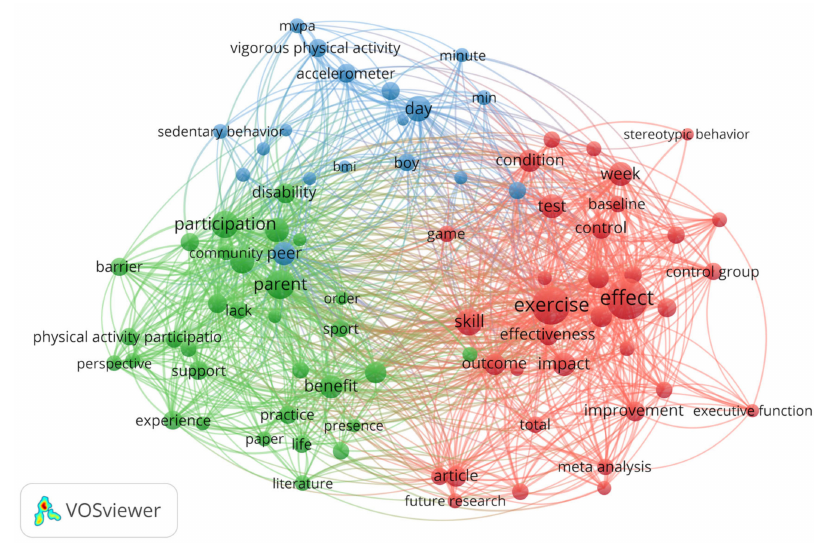
Figure 9. The term co-occurrence network on PA research of